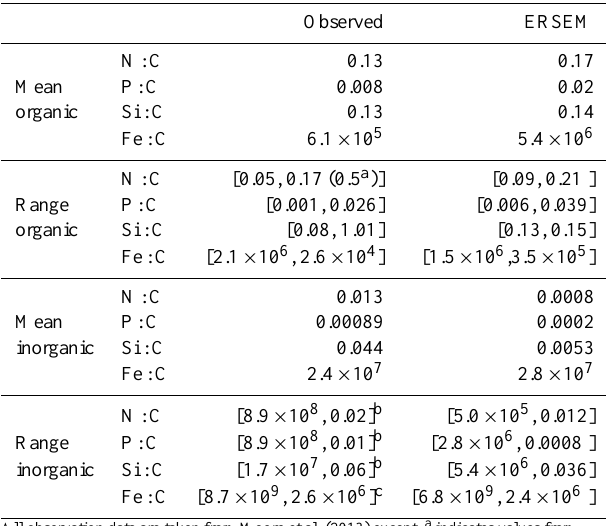
Table 4. Table showing the typical, minimum and maximum or- ganic and inorganic ratios against carbon for Moore et al. (2013) and for the ERSEM